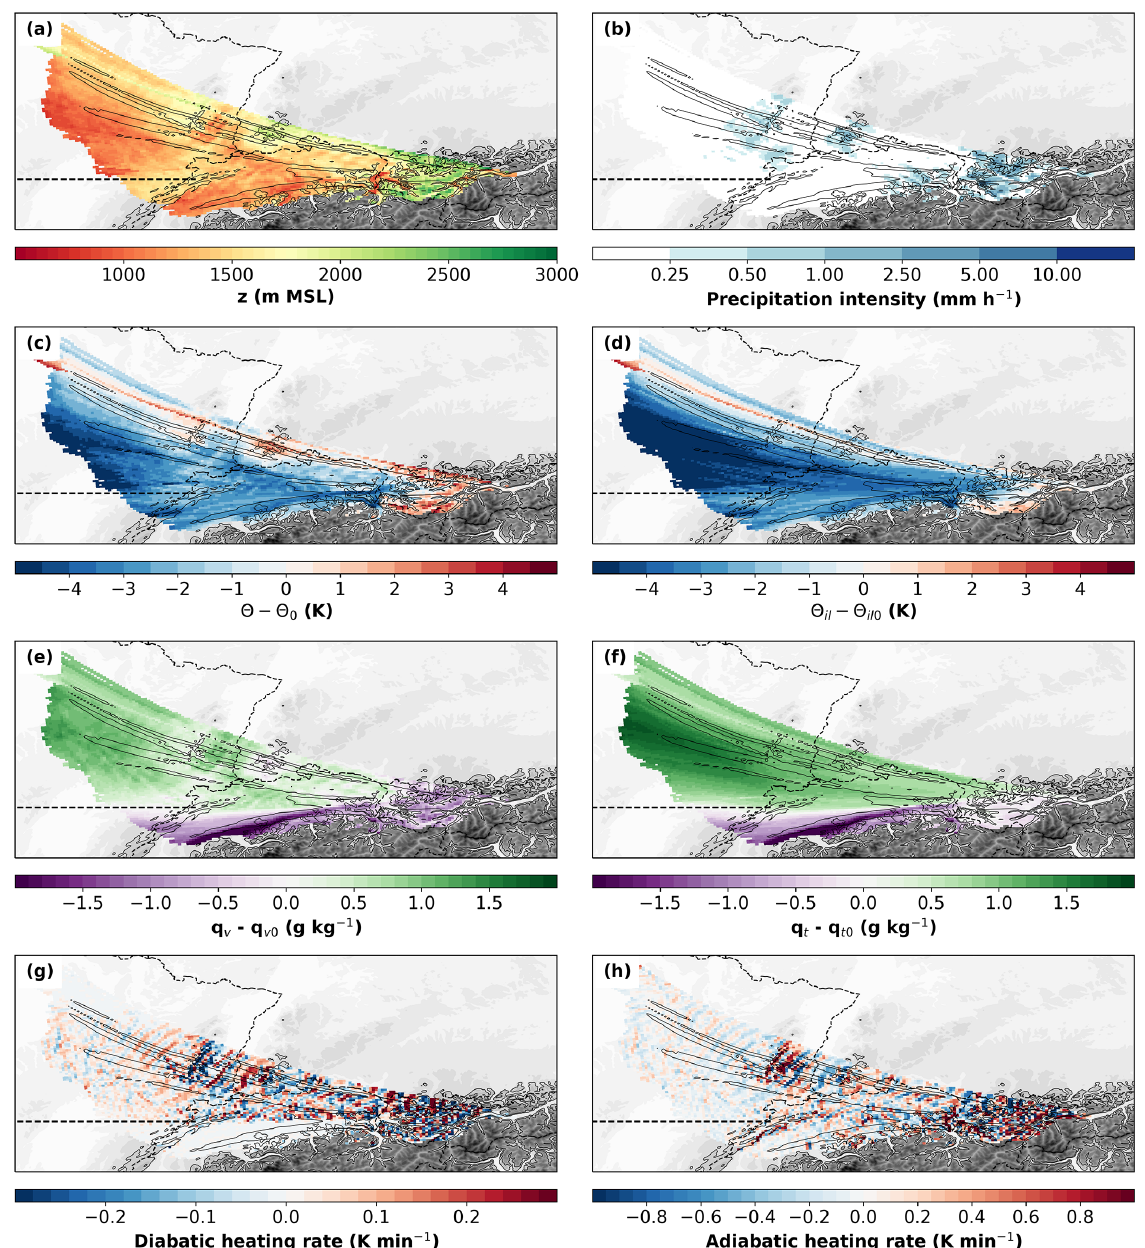
Figure 8. Gridded fields in subdomain SD1 of various trajectory properties for trajectories as shown in Fig. 7. Depicted are the median of (a) trajectory height, (b) precipitation intensity at the surface, (c) potential temperature deviation, (d) ice–liquid potential temperature deviation, (e) water vapor mixing ratio deviation, (f) total water content deviation, (g) diabatic heating rate, and (h) adiabatic heating rate. All deviations refer to the corresponding reference value at the trajectory arrival point Innsbruck. Trajectory properties are indicated by color contours, model topography and national borders are as in Fig 7, and main flow branches are indicated by the contour line of a trajectory density of 0.03 (thin black line). The latitude of 47.2 ◦ N separating the two main trajectory branches is marked by a dashed black